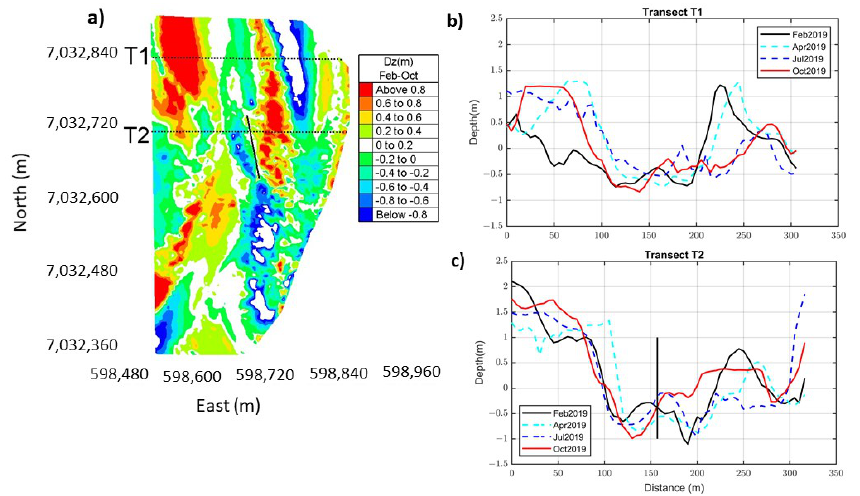
Figure 4. ( a ) Bed level changes during period February 2019 and October 2019; ( b ) Cross transect T1 and ( c ) Cross transect T2 at the SND. The back lines depict the location of the